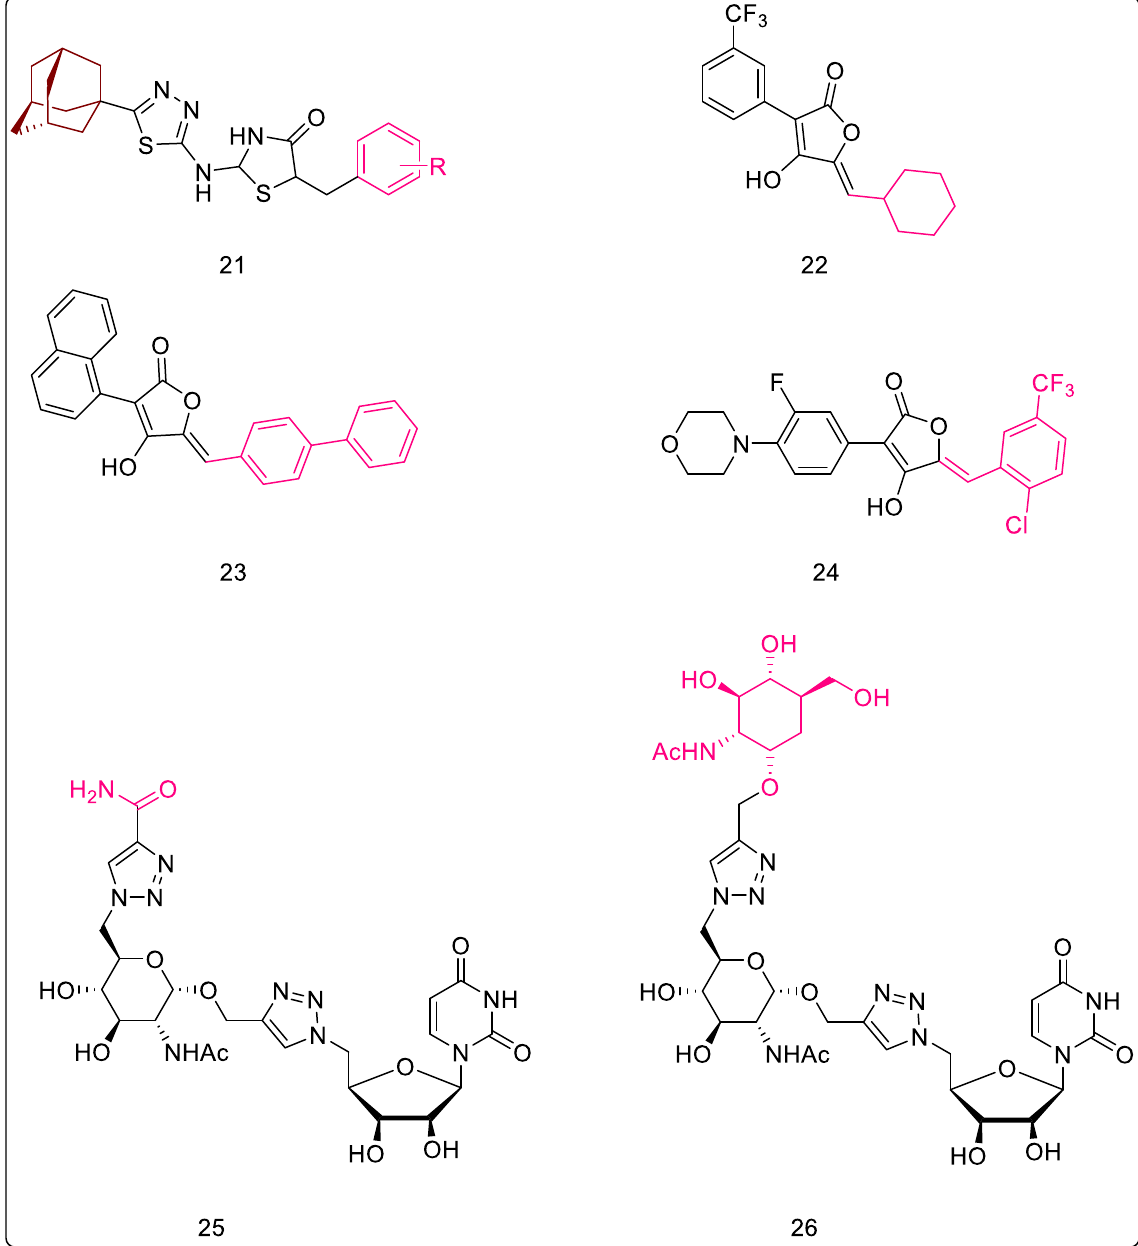
Figure 7. Structural scaffolds of mixed inhibitors. ( 21 ) Adamantan thiadiazole-based thiazolidinones. ( 22 ) Cyclohexylidene derivative of pulvinone. ( 23 ) Biphenyl derivative of pulvinone. ( 24 ) Benzylidene derivative of pulvinone. ( 25 ) 5′ -deoxy- 5′ -(4-substituted-1,2,3-triazol-1-yl)-uridine amide. ( 26 ) Glucosamine derivative.